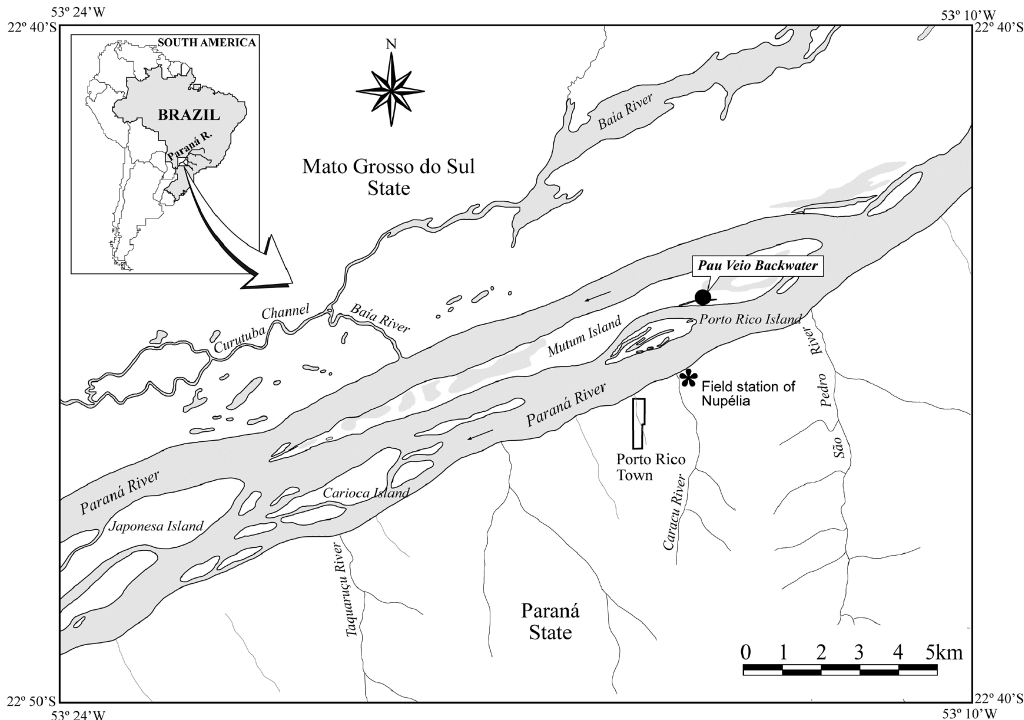
Figure 1. Map and location da sampling